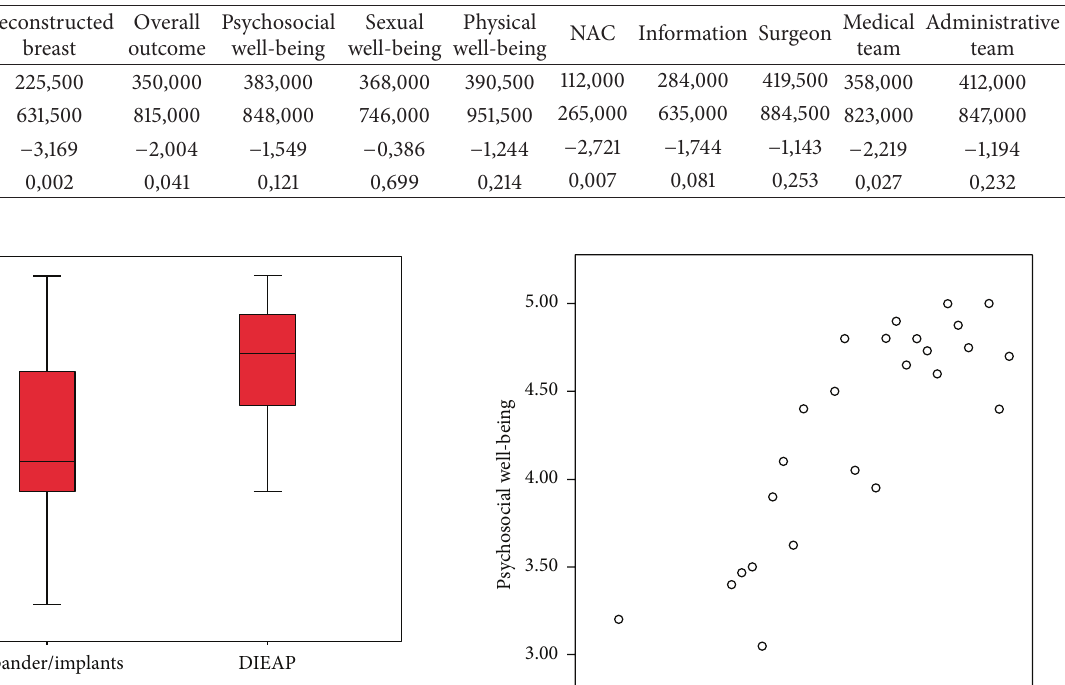
Figure 1: Box plot showing satisfaction with the reconstructed breast.